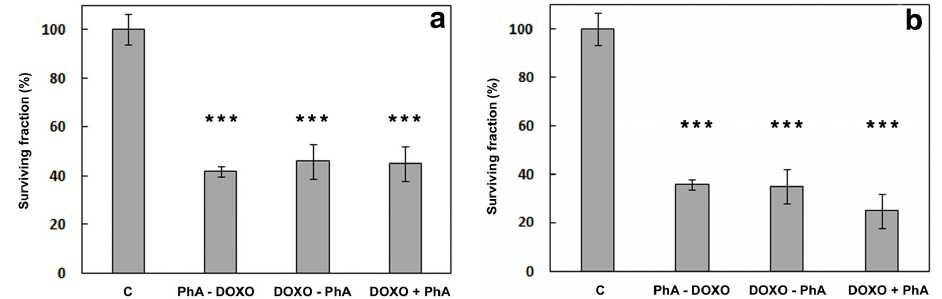
Figure 12. Viability of HeLa cells treated with DOXO 0.4 µ M and PhA 2 µ M according to three different protocols. Samples were either kept in the dark ( a ) or irradiated for 15 min after PhA incubation ( b ). c: non-treated control cells. PhA-DOXO: cells incubated with PhA for 4 h, washed and incubated with DOXO for 24 h. DOXO-PhA: cells incubated with DOXO for 24 h, washed and incubated with PhA for 4 h. DOXO + PhA: cells incubated with DOXO for 20 h, washed and co-incubated with PhA and DOXO for 4 h. *** p < 0.001. SD is the average of at least three separate